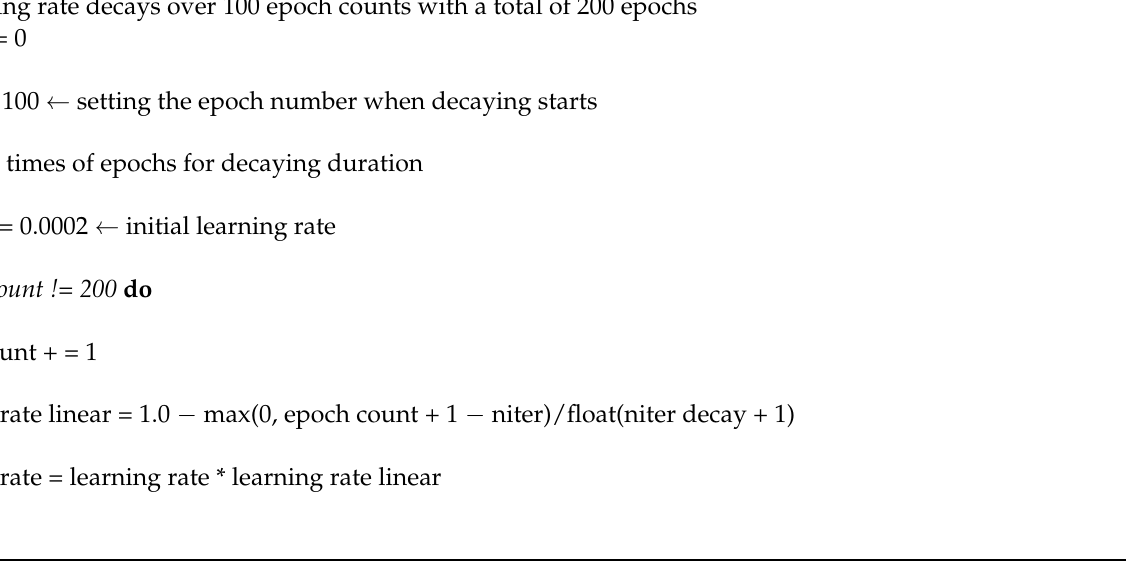
Algorithm 2: Optimizer learning rate